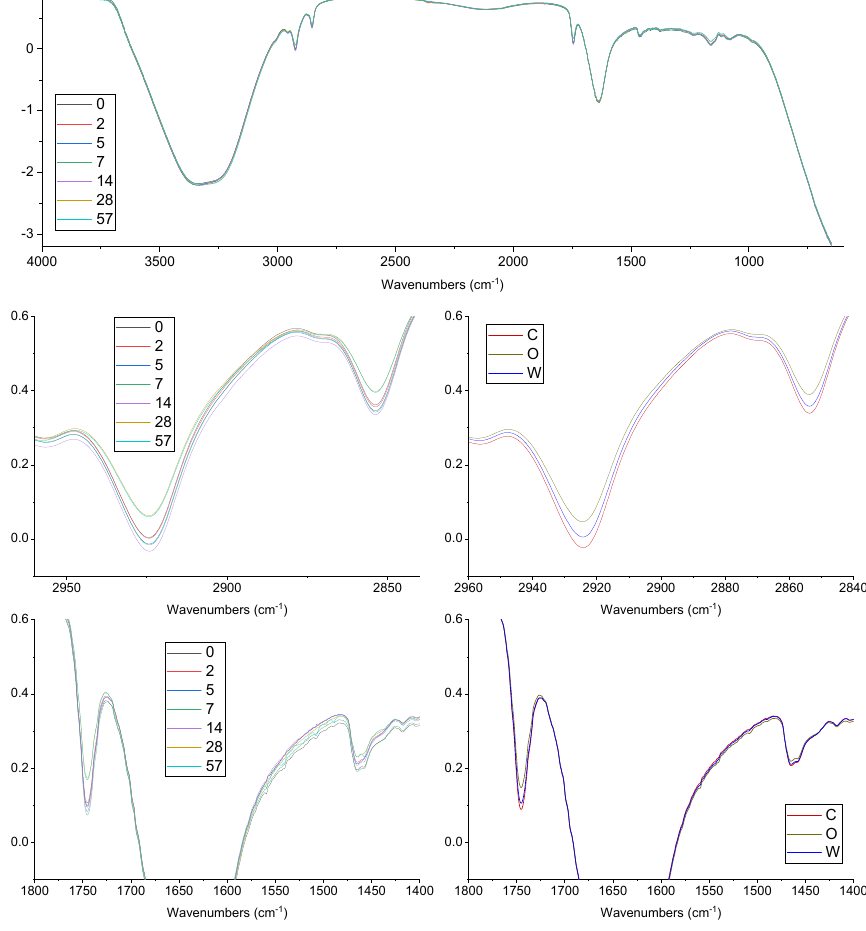
Figure 3. Trend of hydroperoxides in O/W emulsions, added with OPA, during accelerated oxidation test with AAPH radical initiator. C, control emulsion; O, emulsion with OPA added to the oil phase; W, emulsion with OPA added to the water phase. Shah fitting is reported (see text for details on the model).